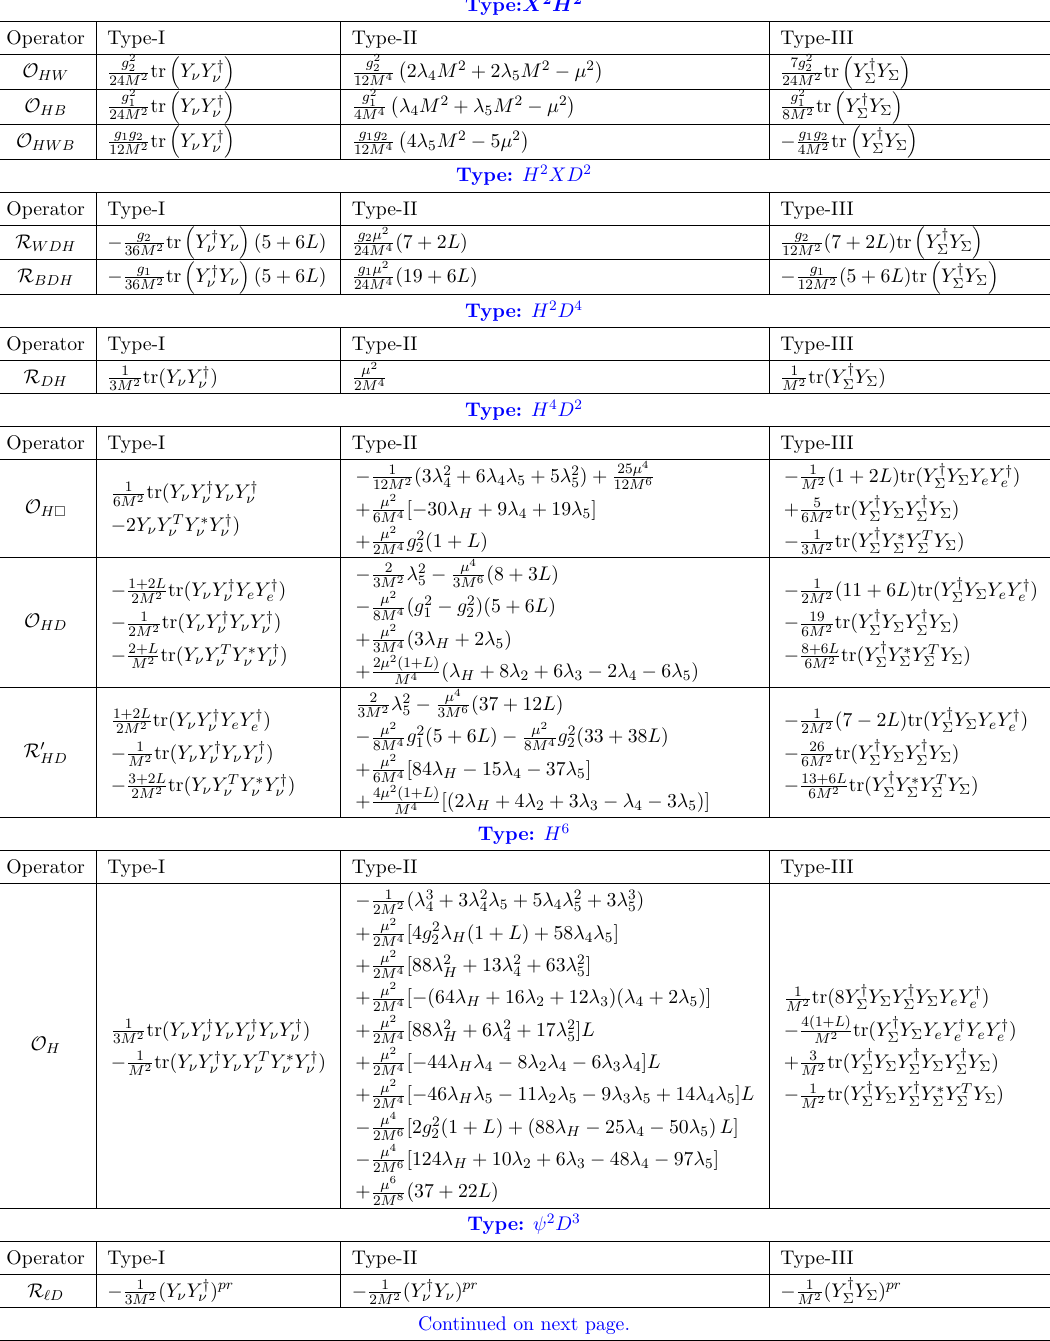
Table 4 . Higher dimensional operators in the Green’s basis from one-loop matching. We classify the operators by their types as specified in blue. The specific forms of these operators are listed in table